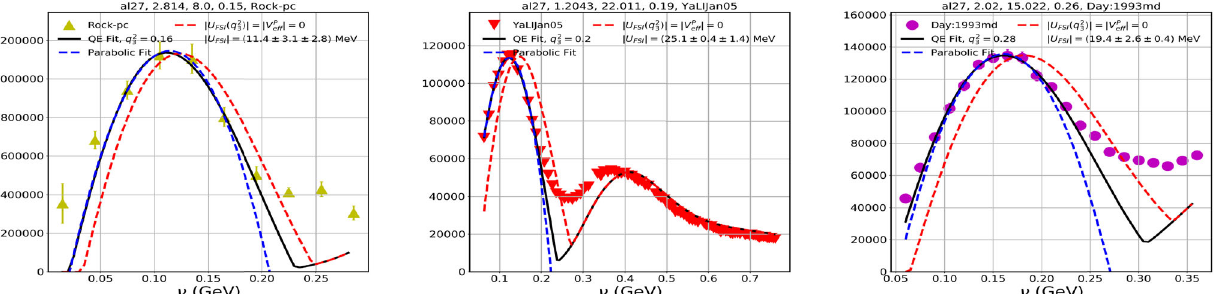
= 0 . 225 GeV) QE differential cross sections O ( k P F 8